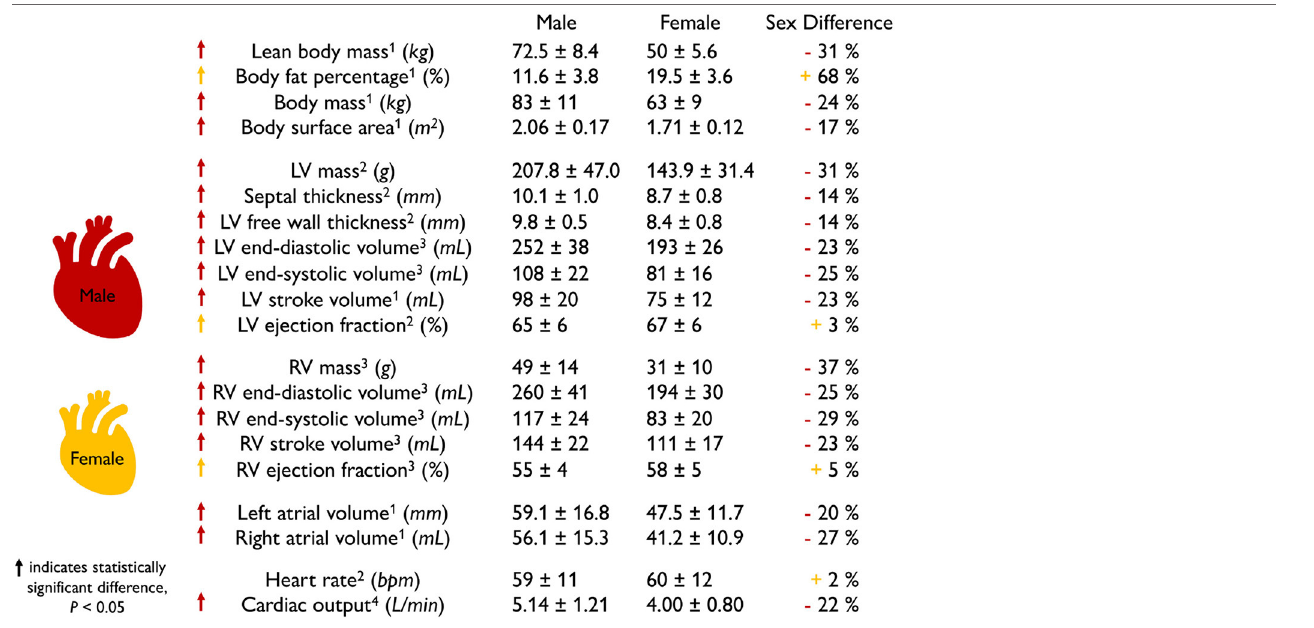
TABLE 4 | Sex differences in athlete’s heart geometry and function.